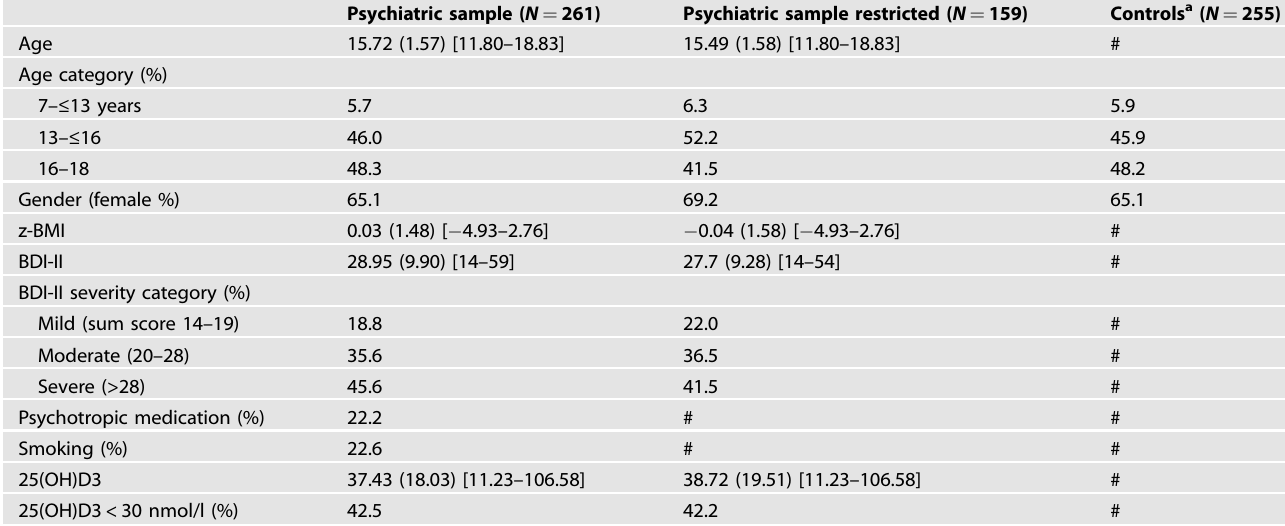
Table 2. Patient